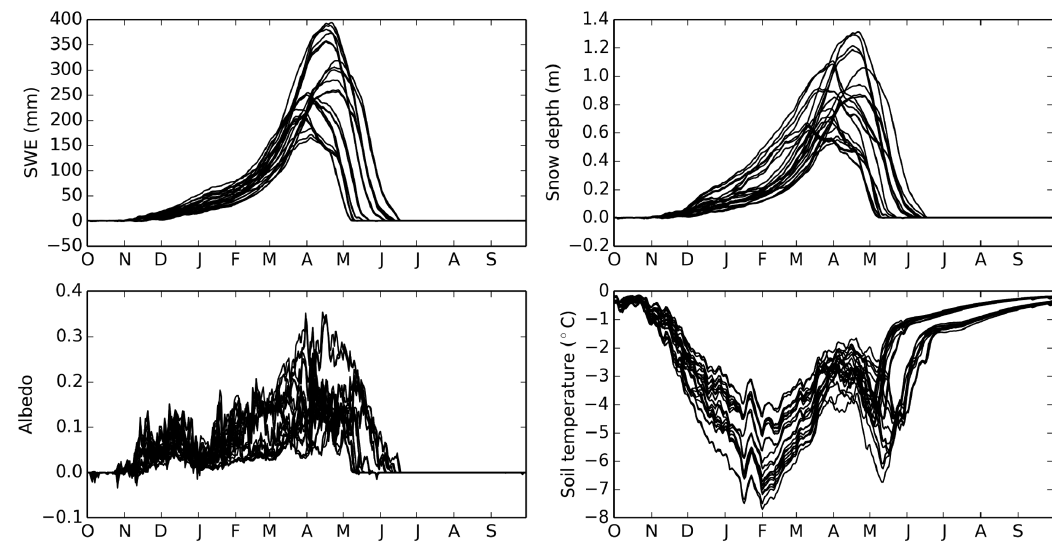
Figure 7. As Fig. 5, but for differences between the 32 FSM ensemble members in simulations without thermal insulation by snow and reference